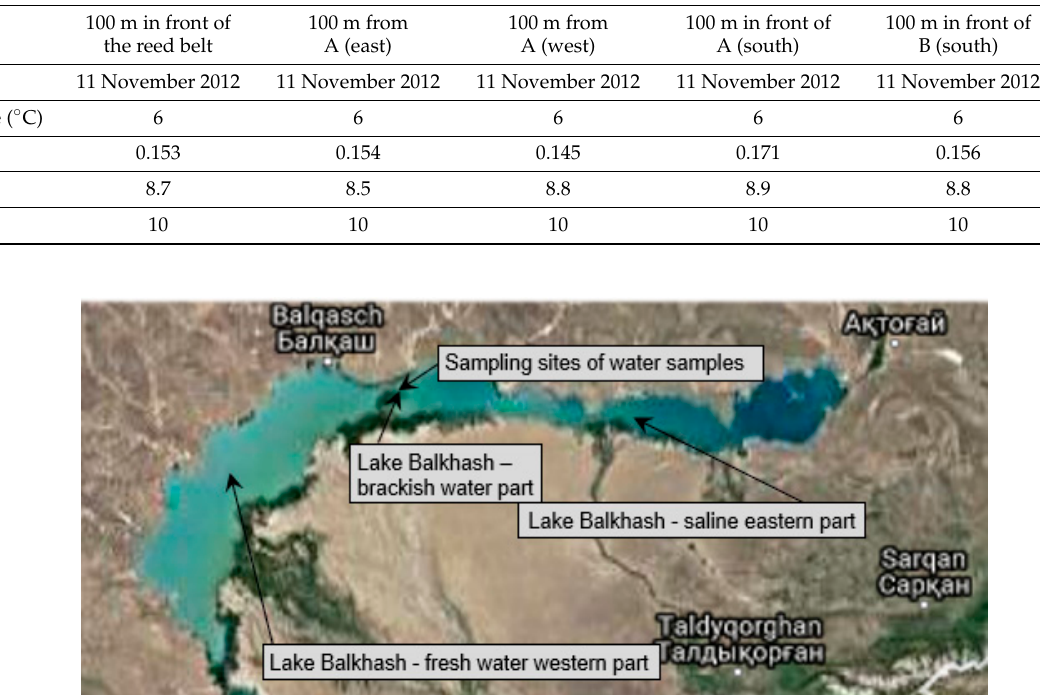
Table 1. Sampling sites and sampling conditions of water samples A–E from Strait Uzynaral, Lake Balkhash (Kazakhstan).